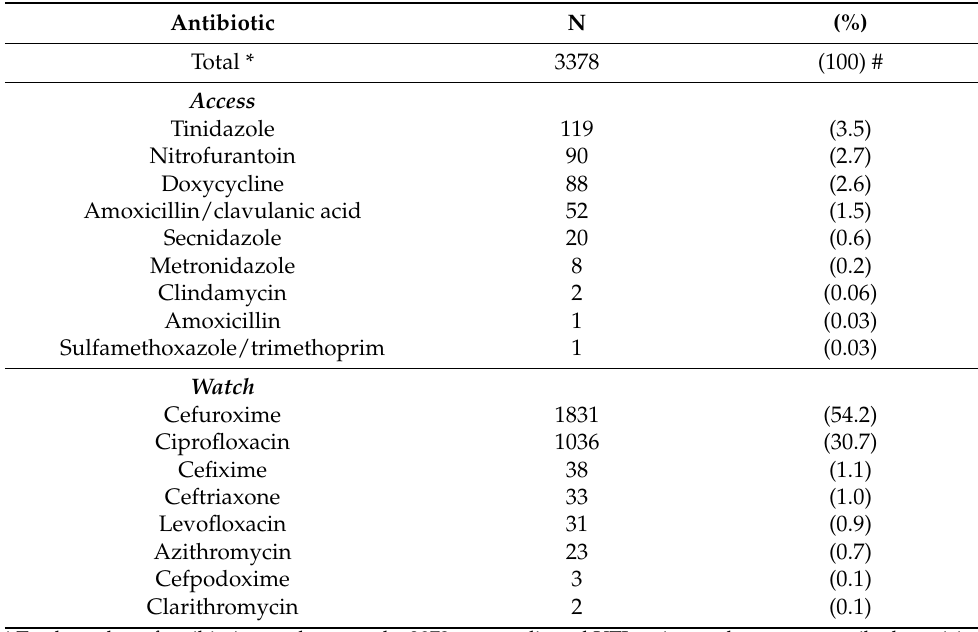
Table 3. Distribution of empirical antibiotics across WHO AWaRe categories prescribed for adults diagnosed with uncomplicated UTIs in the outpatient department of the Korle Bu Polyclinic/Family Medicine Department of Ghana during October 2019 to October